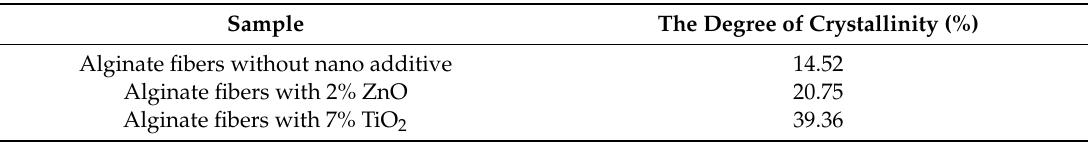
Table 1. Comparison of the degree of crystallinity of the obtained fibers. Sample The Degree of Crystallinity (%) Alginate fibers without nano